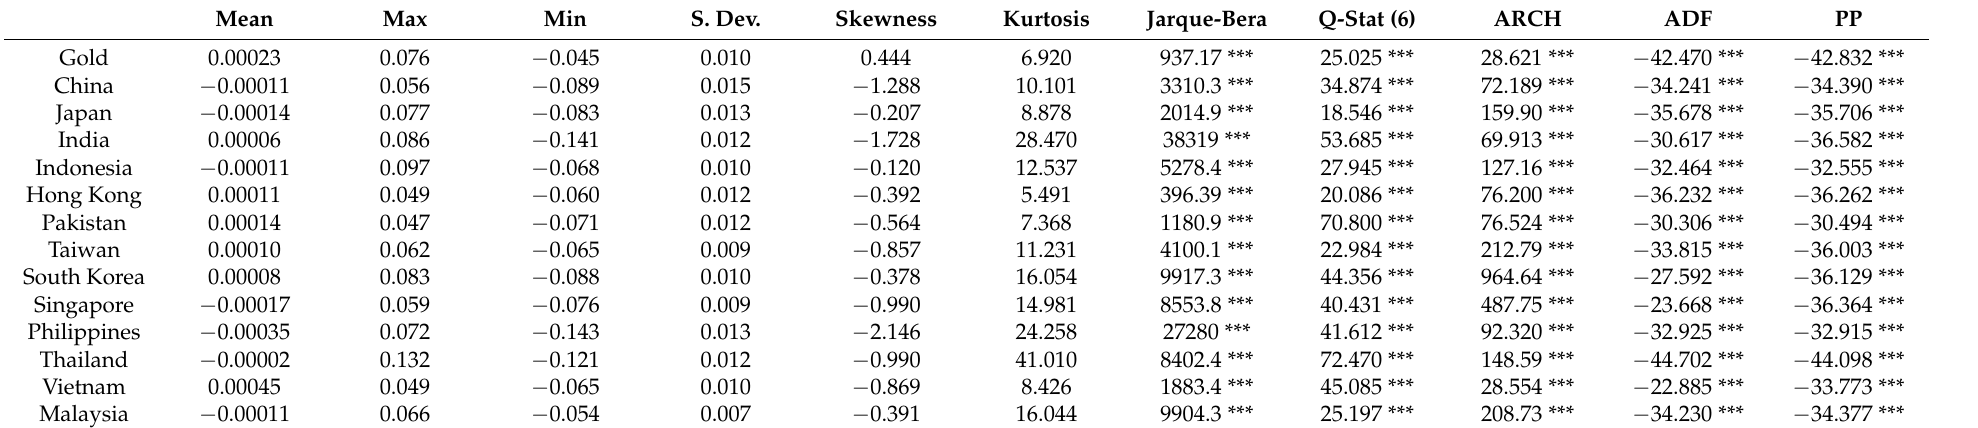
Table A2. Additional tests on full sample